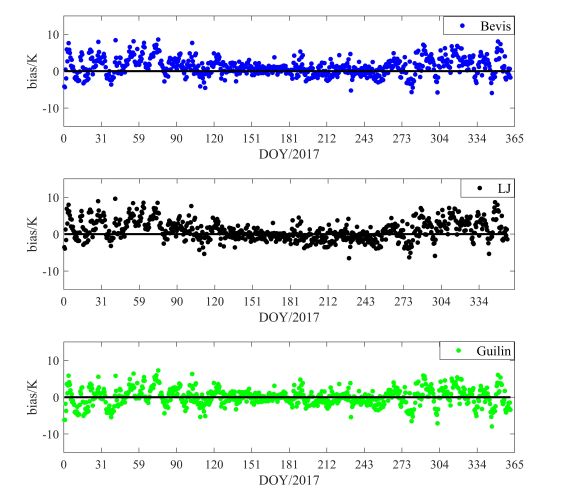
Figure 4. The bias between T m values of the 3 kinds of models and reference values model fluctuate around 0 K, and volatility is relatively uniform throughout the whole year. However, the bias values of Bevis model and LJ model are slightly larger, especially in spring and winter, it fluctuates greatly, and most of the bias values are above 0, which is a positive bias. Bevis model and LJ model are greatly influenced by the seasons. But, a few of T m values calculated from the three models have a large deviation from the reference value especially in spring and winter, which may be caused by a large change of water vapor in a certain period, and the specific reasons need to be further